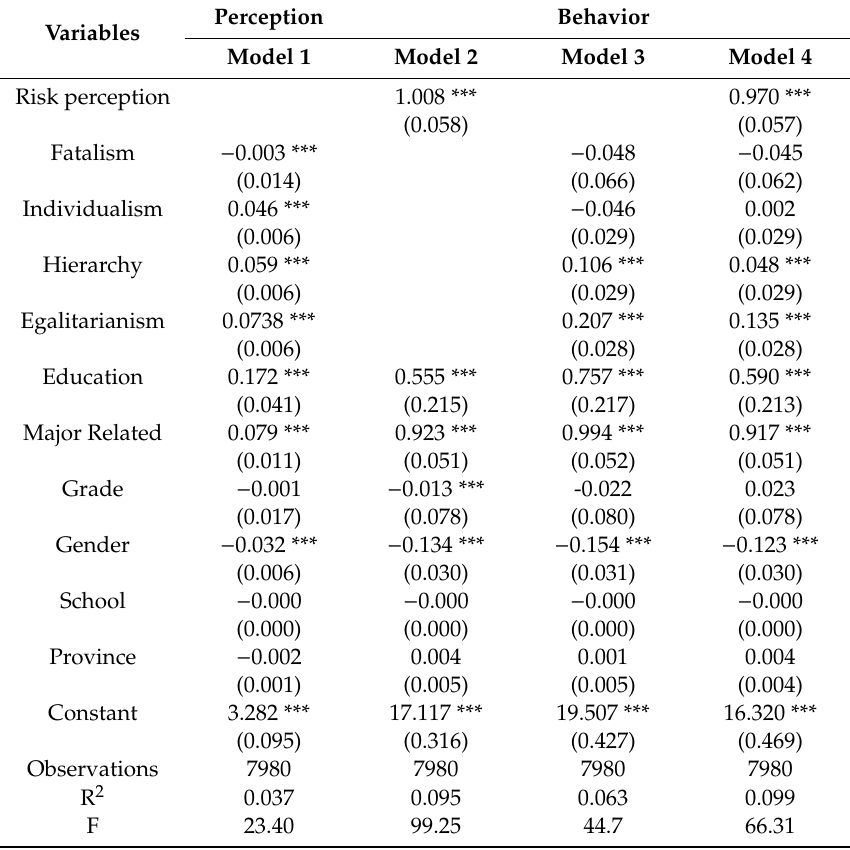
Table 6. Regression results (Risk Cultural